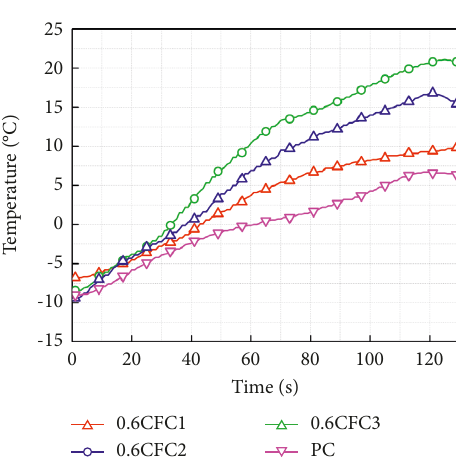
Figure 15: Comparison of temperature rise rate curves under different doping amounts.